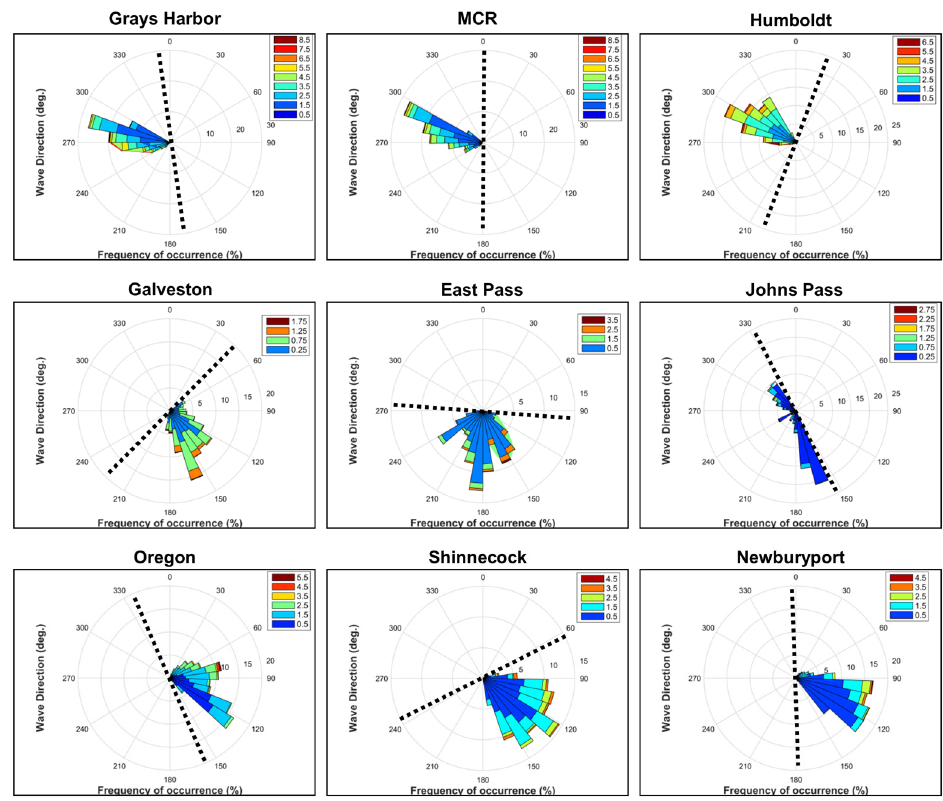
Figure 3. Wave conditions at the nine inlets. Dashed line denotes shoreline orientation and wave height is in meters. Open boundary conditions are prescribed along the three offshore boundaries and closed boundary conditions along the shoreline, inlet and bay. All three of the offshore boundaries are forced by water surface elevation derived from the tidal constituents. The offshore water surface elevation is adjusted to account for wave forcing [13]. The waves are applied on a separate grid with identical spatial coverage as the flow grid. The wave directional spectra characteristics are prescribed at the offshore boundary and generate a wave field across the entire offshore boundary for each time step. The closed boundaries are rigid and do not deform during the simulation. The interior region includes wetting and drying so that shoals can become exposed during low tide. Morphological